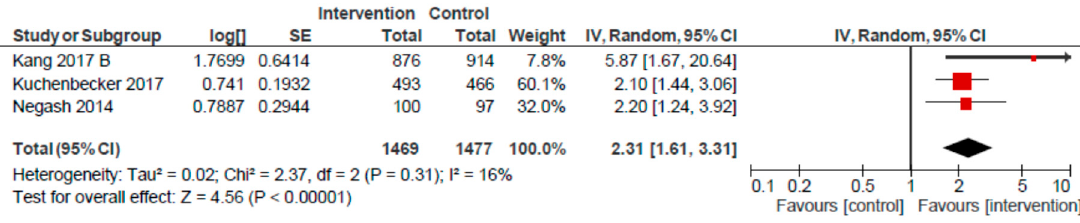
Figure 4. Forest plot of the meta-analysis of child minimum meal frequency for mother/peer groups.